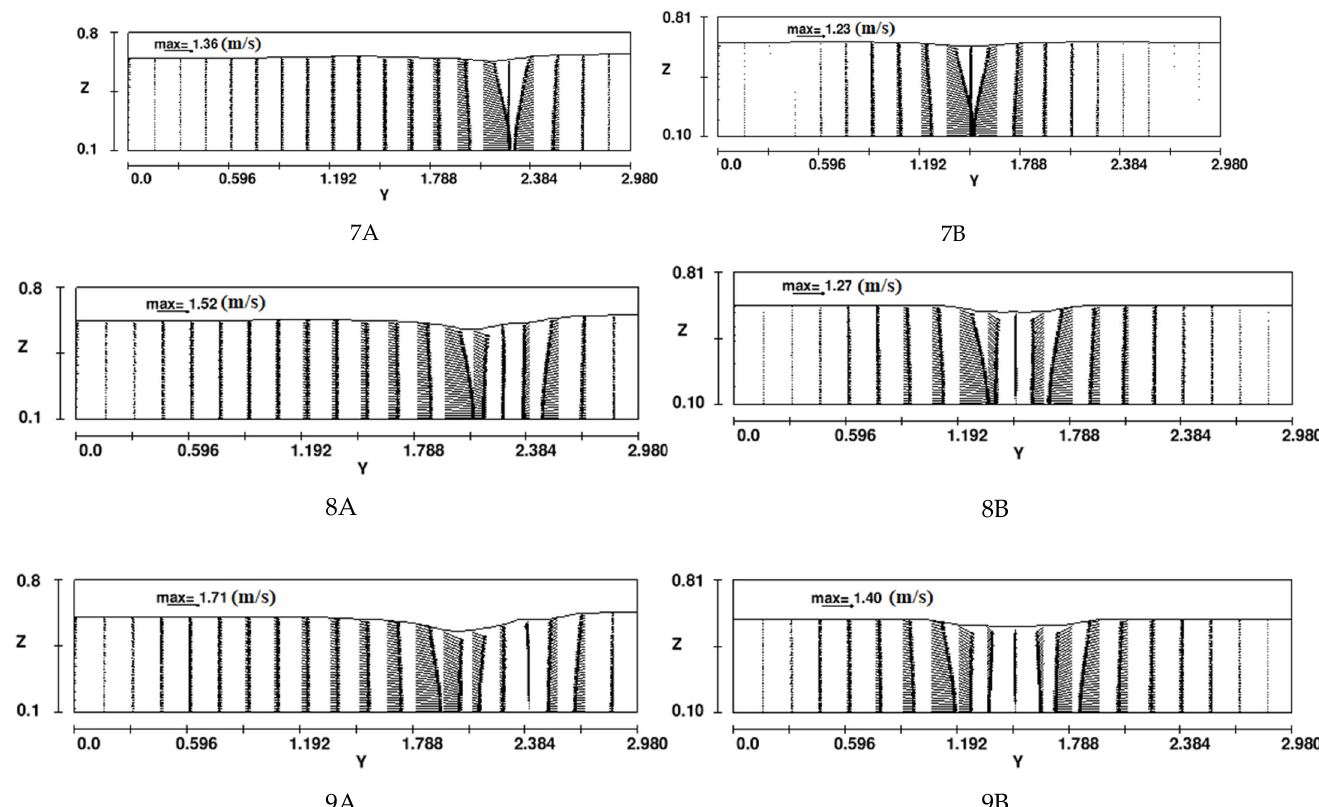
Figure 8. Distribution of transverse v velocity near dam site at t = 1.5 s.